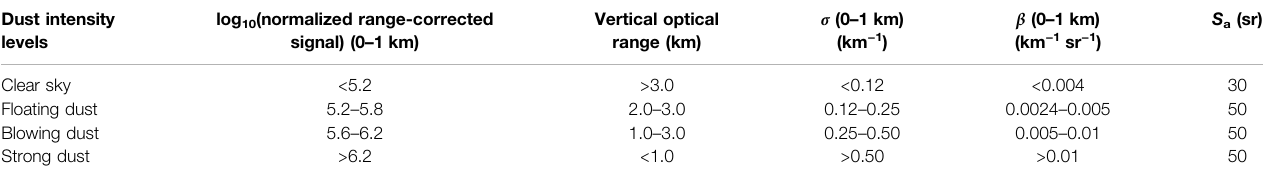
TABLE 1 | Statistics of aerosol optical parameters under different levels of dust intensity during summer 2019 at Tazhong. Dust intensity log 10 (normalized range-corrected levels signal) (0 – 1